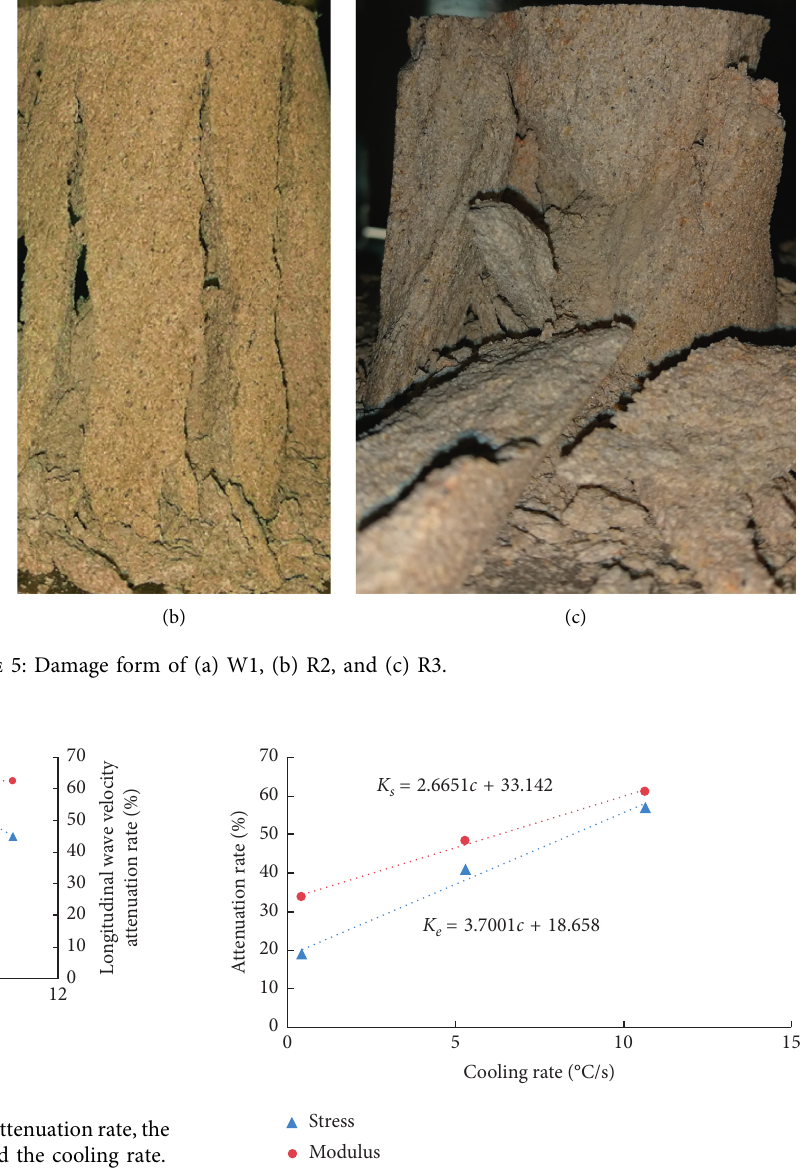
Figure 7: The relationship between the strength attenuation rate, Young’s modulus attenuation rate, and the cooling